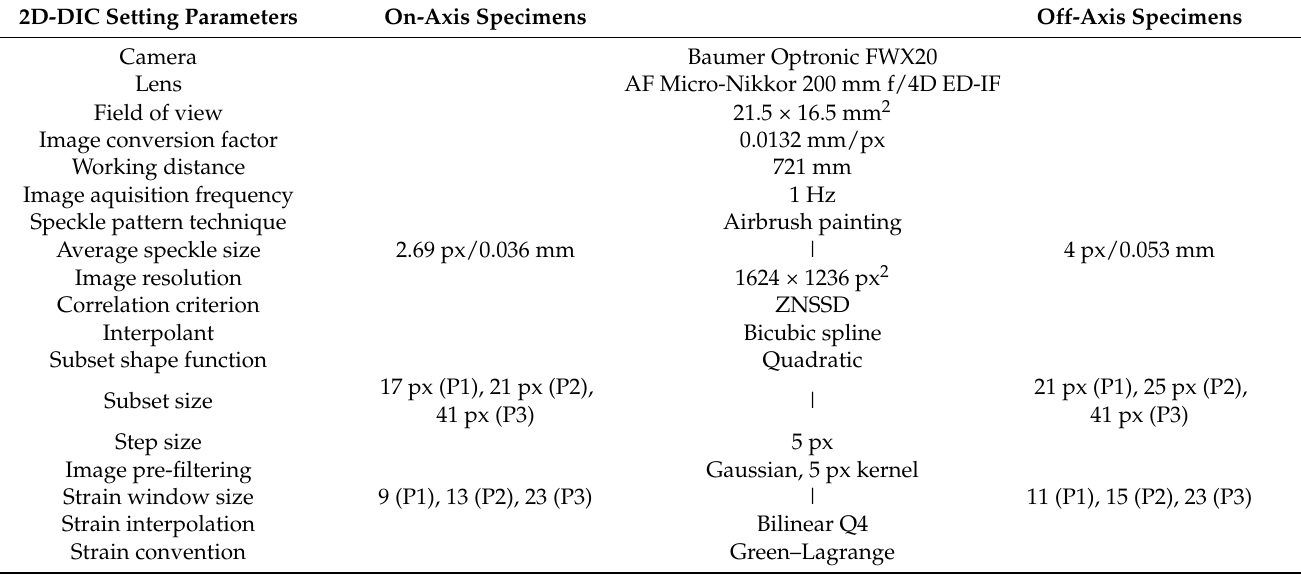
Table 2. 2D-DIC settings used for the experimental DIC measurements using MatchID DIC Soft- ware